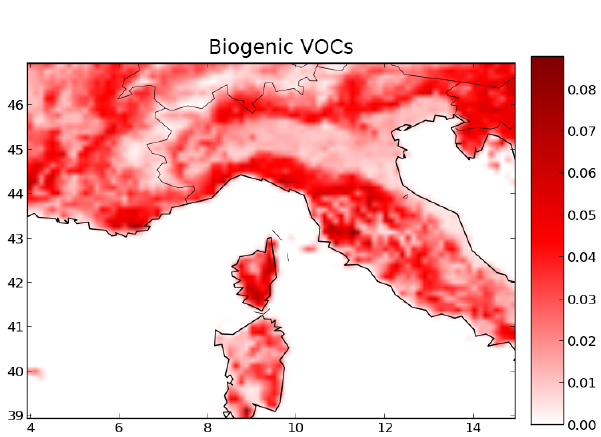
Figure E1. Maps of the emission rates of biogenic VOCs (isoprene and terpene) during the summer 2013 in µgm − 2 s − 1